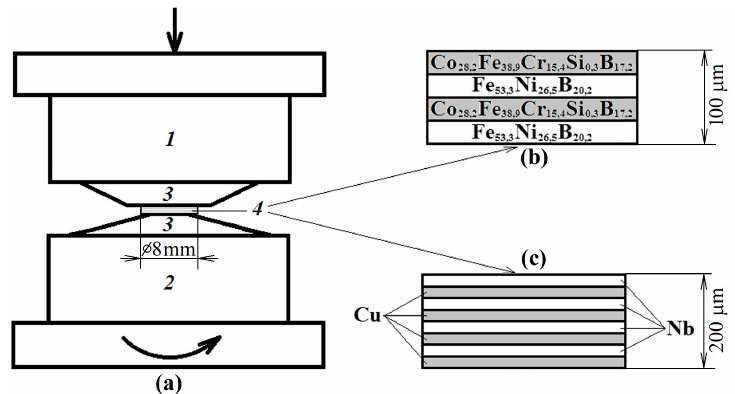
Figure 1. ( a ) Severe plastic deformation (SPD) scheme for the composite preparation: Bridgman chamber consisting of immobile 1 and movable 2 anvils, carbide inserts 3 , sample 4 of alternating amorphous alloys (AA) ribbons ( b ) or the Cu-Nb nanolaminate ( c ).